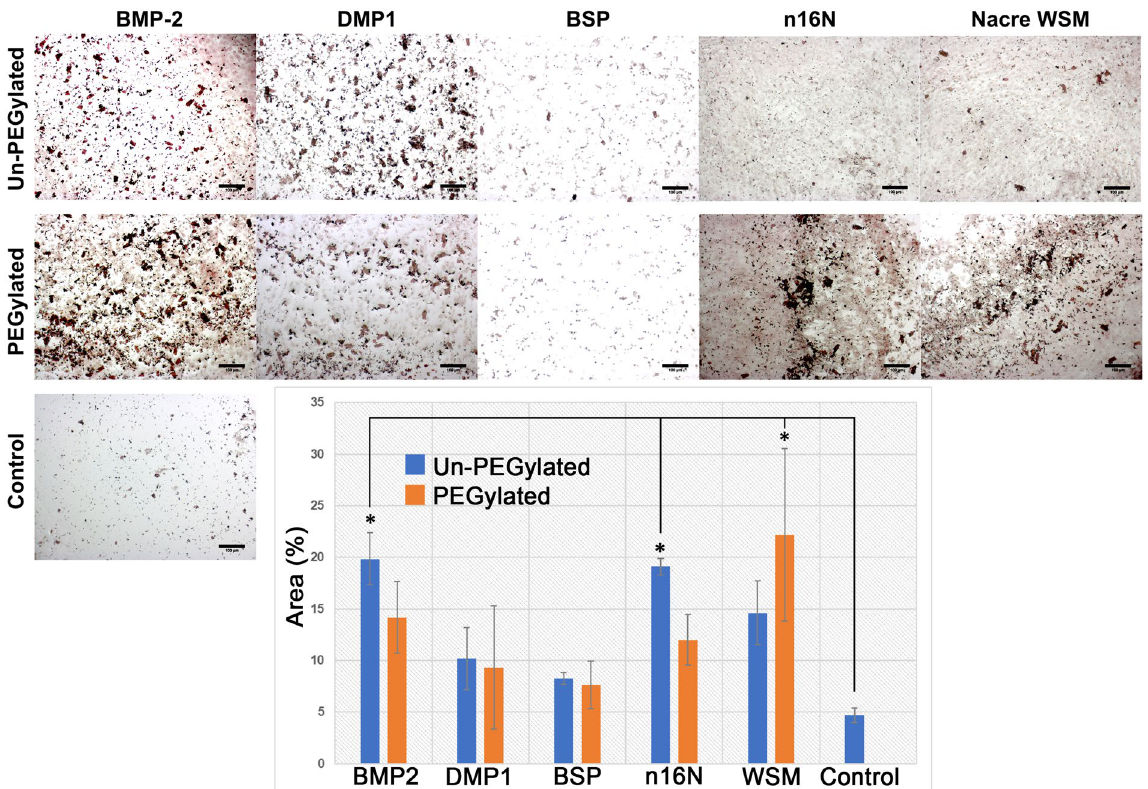
Figure 6. MC3T3-E1 cells on PEGDA hydrogels incorporating PEGylated and non-PEGylated proteins. Cells stained with Alizarin red S to visualize calcium, which is stained red. Error bars represent standard deviation. Scale bars are 100 µm. Asterisks denote significant difference between sample and protein negative control ( p < 0.05). Images were uniformly adjusted for brightness and